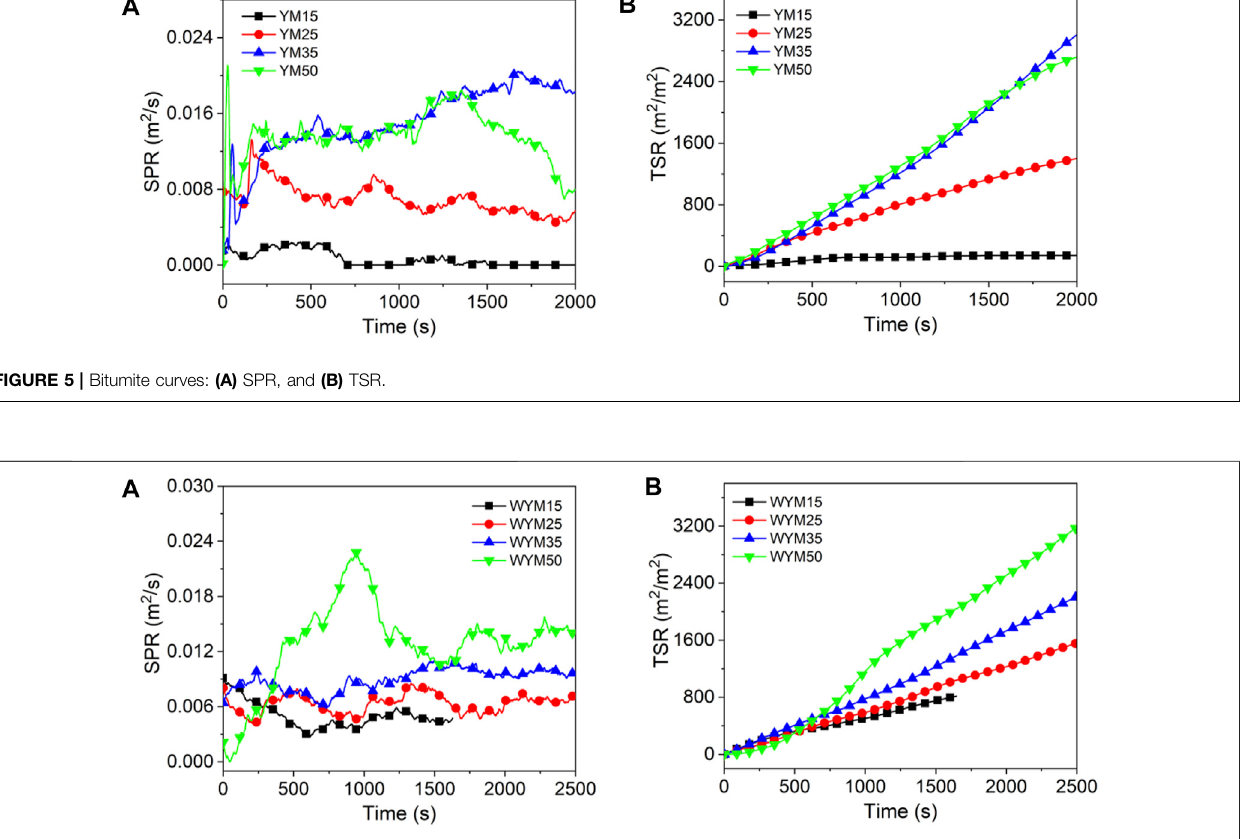
FIGURE 6 | Anthracite curves: (A) SPR, and (B) TSR.